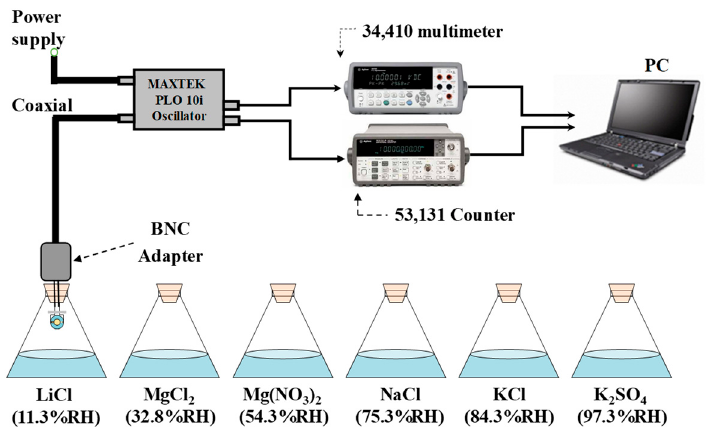
Figure 3. The schematic diagram of the humidity-sensitive experimental setup.